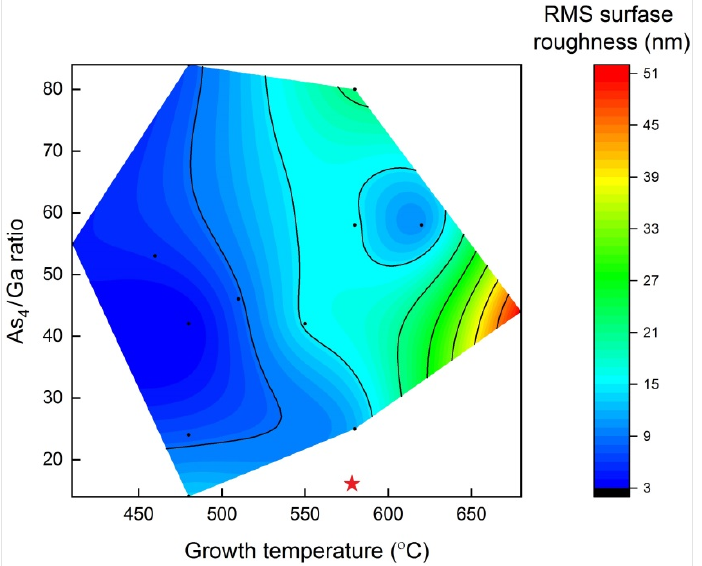
Figure 3. Root mean square roughness vs. growth temperature and As 4 /Ga ratio (black dots are experimental measurements, out-of-order sample #87 with hole conductivity and with extra-large surface roughness 117 nm is marked by asterisk outside the interpolation area).